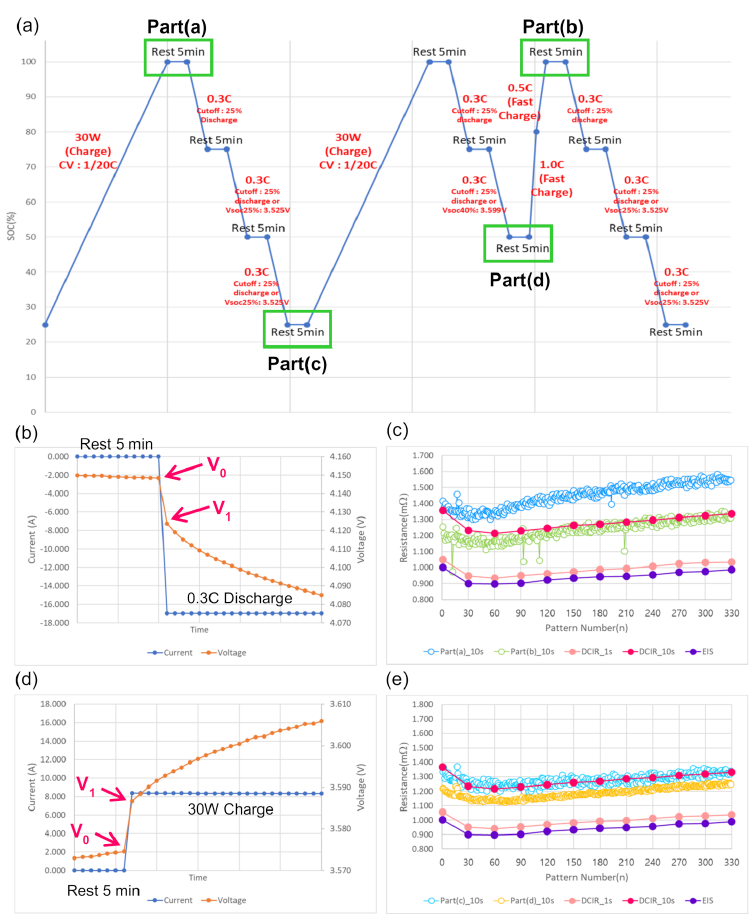
Figure 8. DCIR of the “stop-operation” part after V0G pattern repetition. ( a ) V0G pattern and the “stop-operation” part, ( b ) Changes in current and voltage at Part (a), ( c ) Comparison of DCIR between parts (a, b), ( d ) Changes in current and voltage at part (c), ( e ) Comparison of DCIR between parts (c,